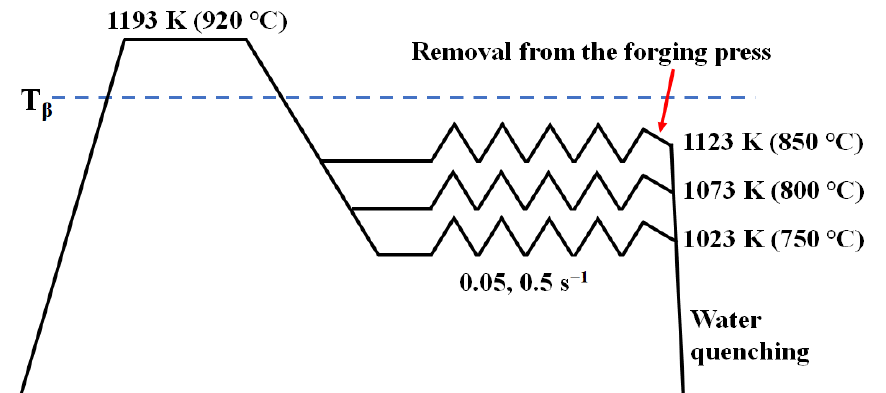
Figure 2. Schematic of the temperature – time sequences of the thermomechanical processes.